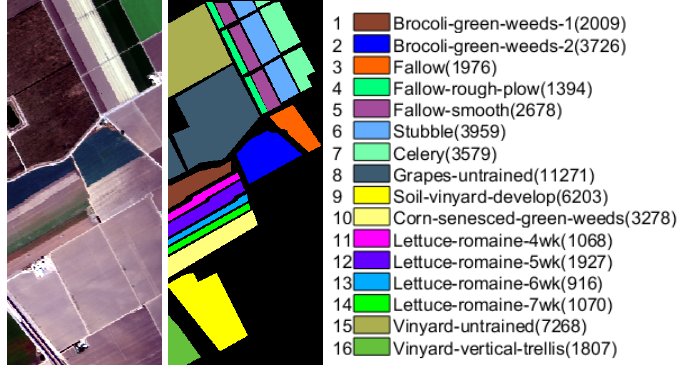
Figure 4. The false color composition and ground truth of Salinas data with numbers of samples for each class in